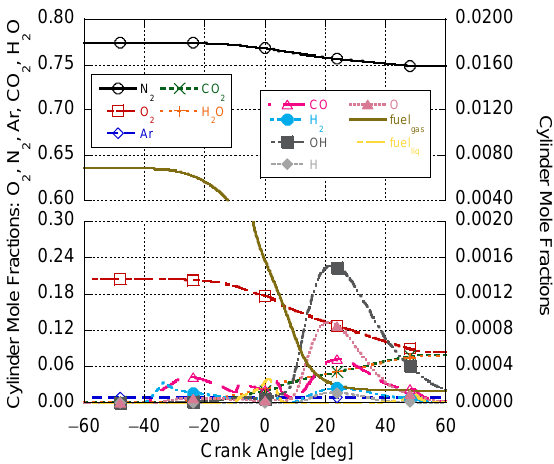
Figure 7. Global mole fractions of the chemical species in the cylinder as a function of crank angle for the expanded combustion reaction.